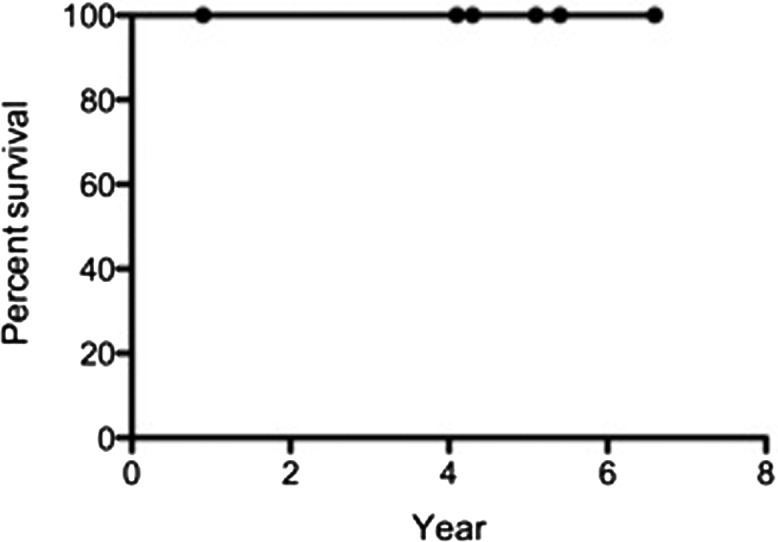
Overall survival.